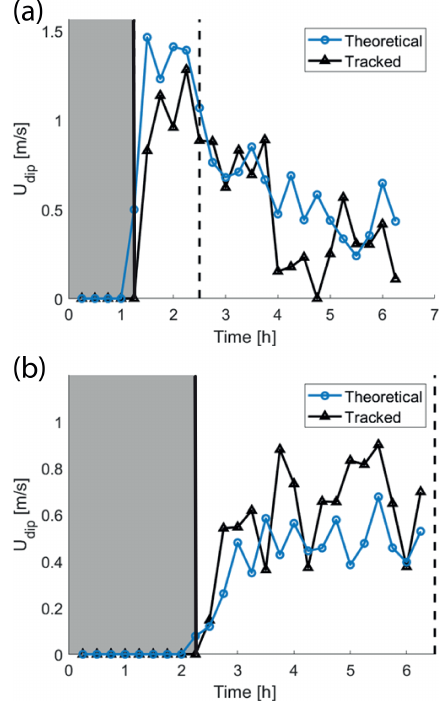
Figure 15. Dipole propagation velocity for a dipole formed in (a) the 1km wide and 4km long strait shown in Fig. 5, as well as (b) the 4.5km wide and 4km long strait shown in Fig. 6. The black curves are velocities obtained from dipole tracking, while the blue curves are velocities calculated using Eq. (15). The gray patch indicates the time before flow separation. The dashed black line in- dicates when the dipole escapes the sink region.